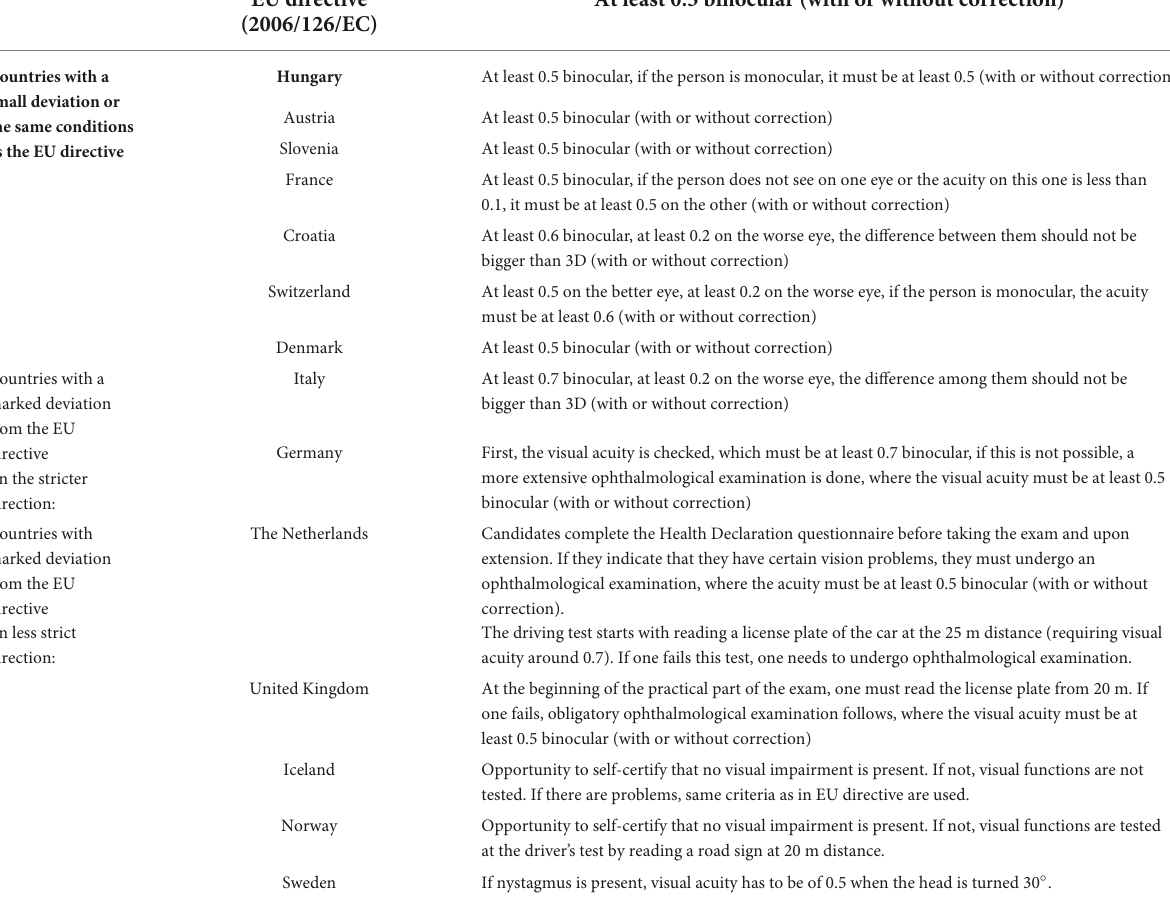
TABLE 1 European Union visual acuity requirements and comparison of the requirements among selected European countries according to the degree of deviation. EU directive At least 0.5 binocular (with or without (2006/126/EC)